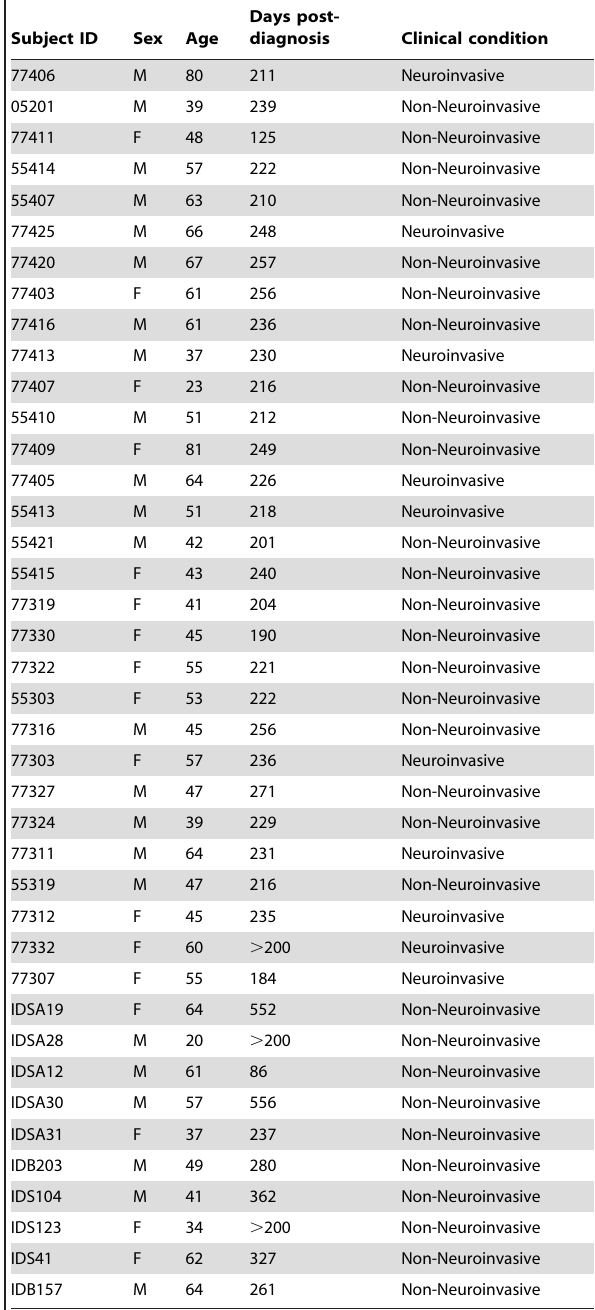
Table 3. WNV infected